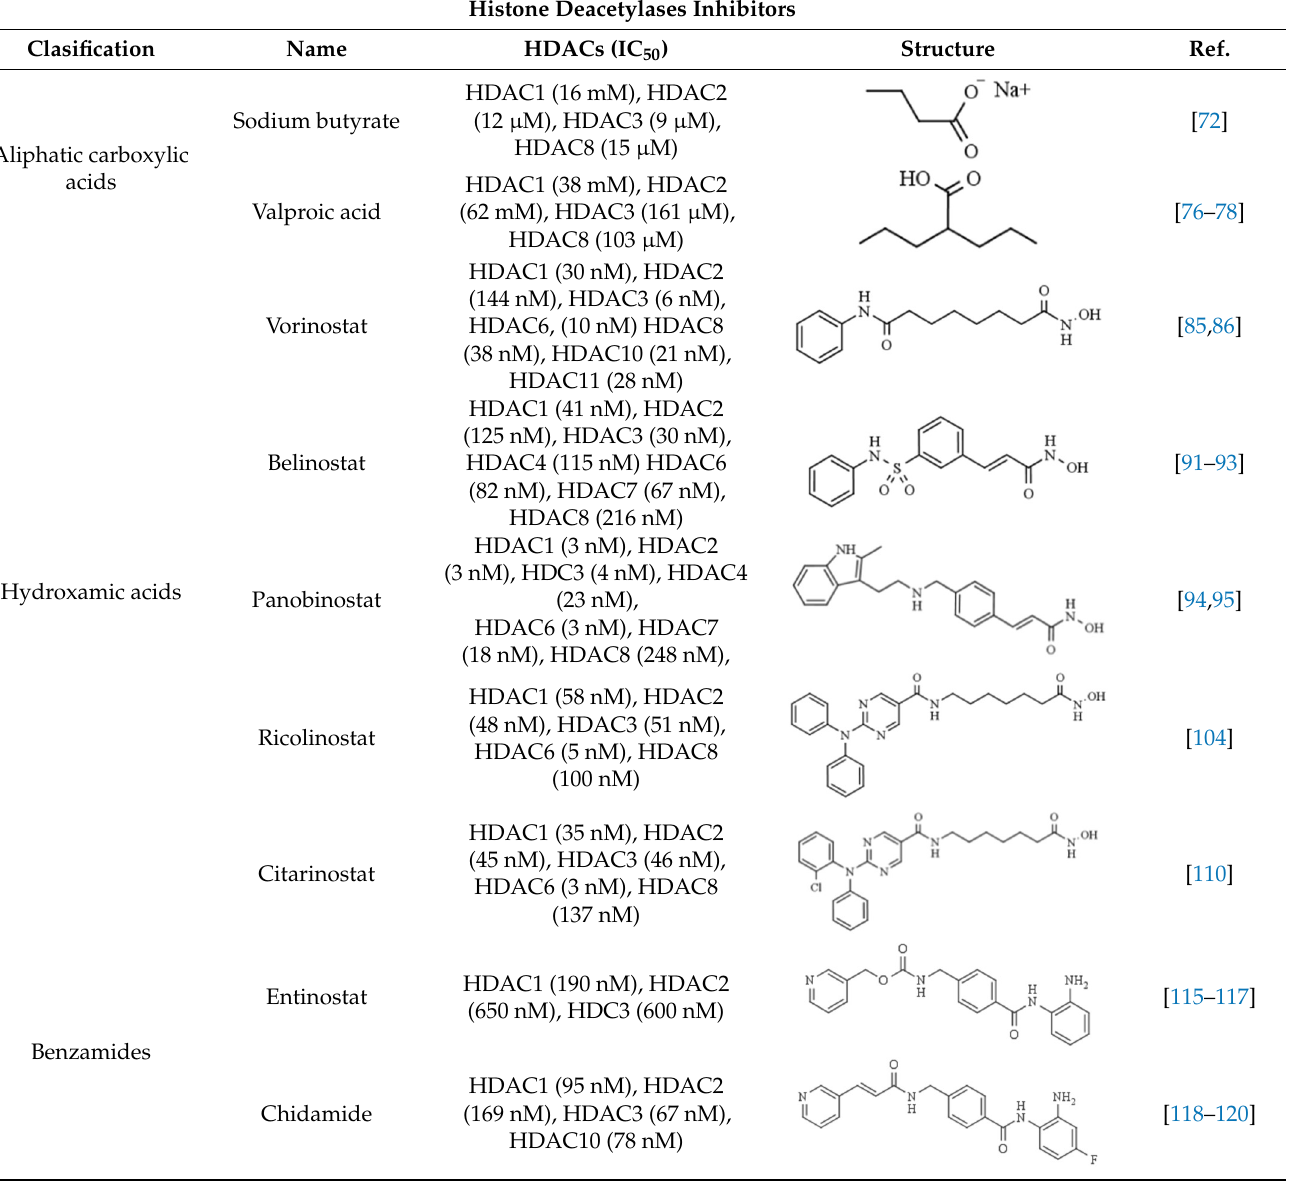
Table 2. Selected HDAC